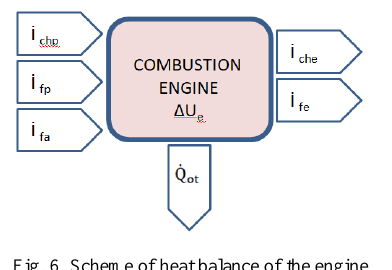
Fig. 6. Scheme of heat balance of the engine